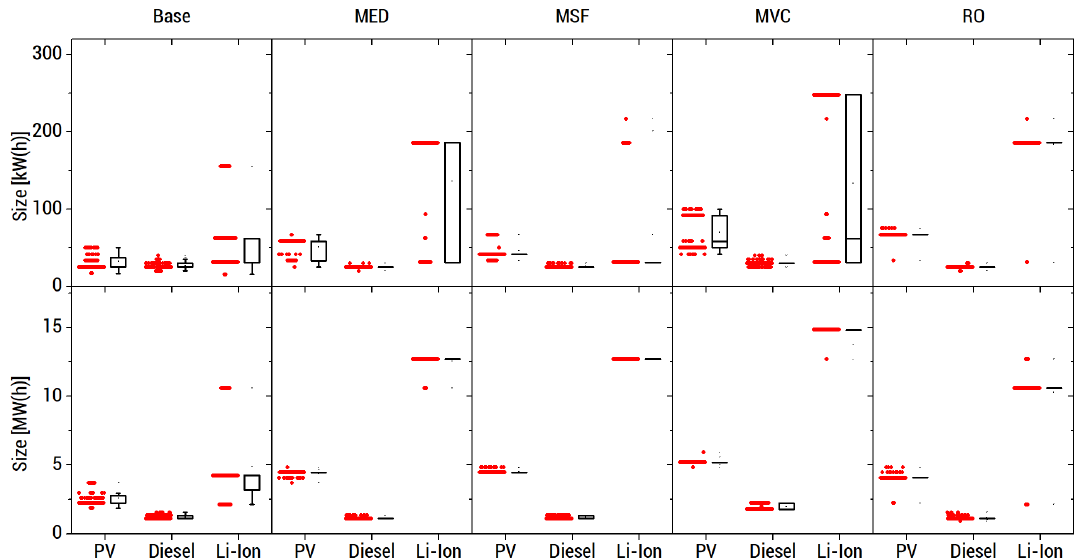
Figure 8. Distribution of optimum sizes of energy components on Camasusu Island ( top ) and Lubang Island ( bottom ). Systems in Camasusu have small Li-ion BESS installation sizes, except for RO, where the Li-ion BESS installation is large. Systems in Lubang have large Li-ion BESS installations.